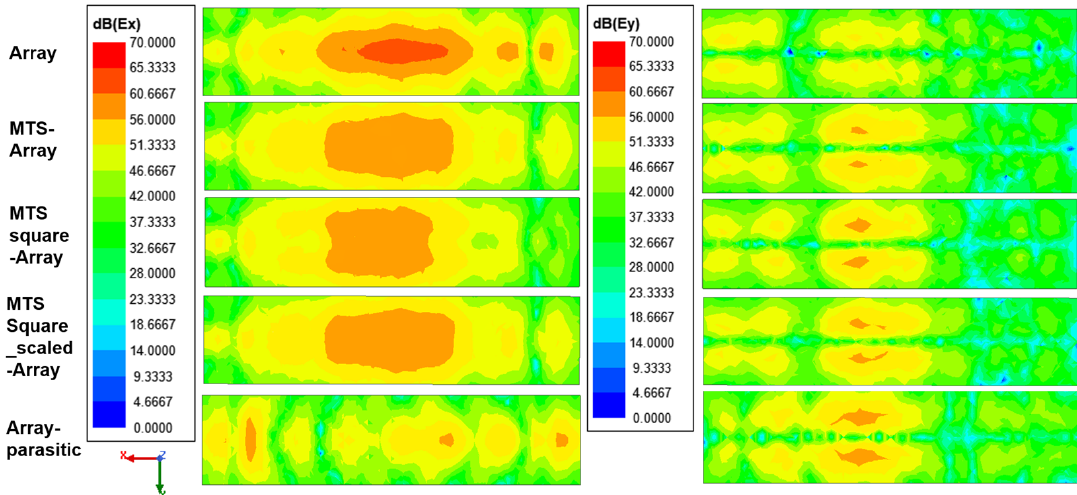
Figure 13. Tangential components of the electric fi eld, Ex and Ey, at 24.15 GHz for the antennas under analysis, in a plane located a short distance above the antenna.